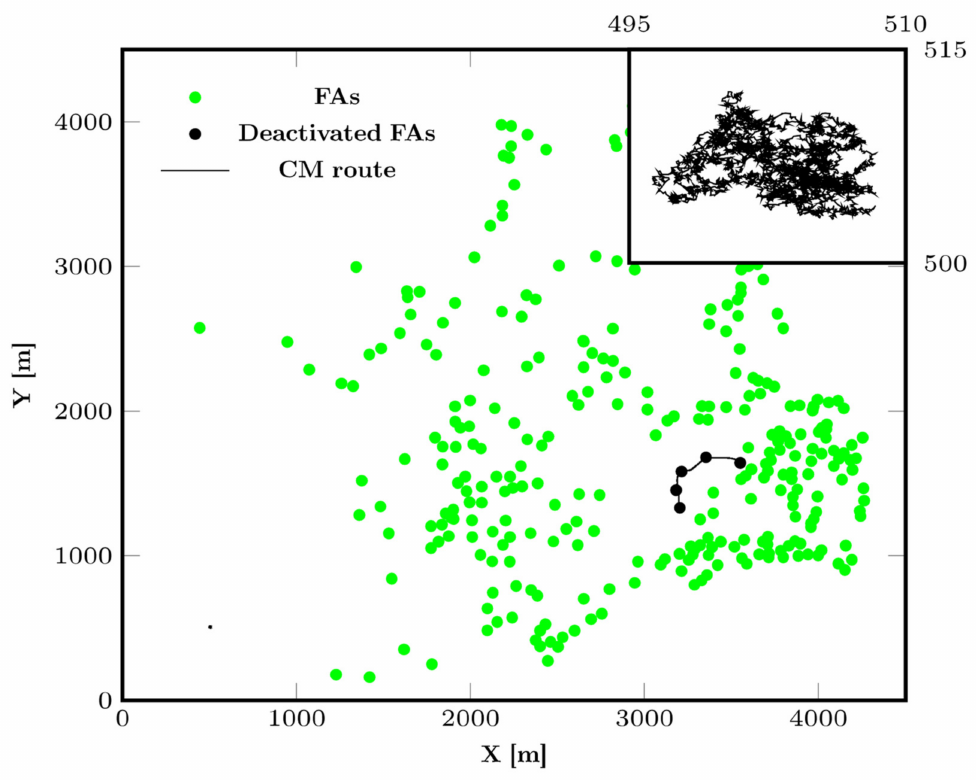
Figure 5. CM trajectories on a map of high food availability in the dry evergreen forest with control parameters abundanceReach = 1 and explorationZone = 1 ( left trajectory ) as well as abundanceReach = ∞ and explorationZone = 2 ( right trajectory ). In both cases, velocity = levyRatio = 1. Deactivated FAs are those through which the group’s CM has passed within precisionCM meters. A magnification of the left CM trajectory is shown in the upper right